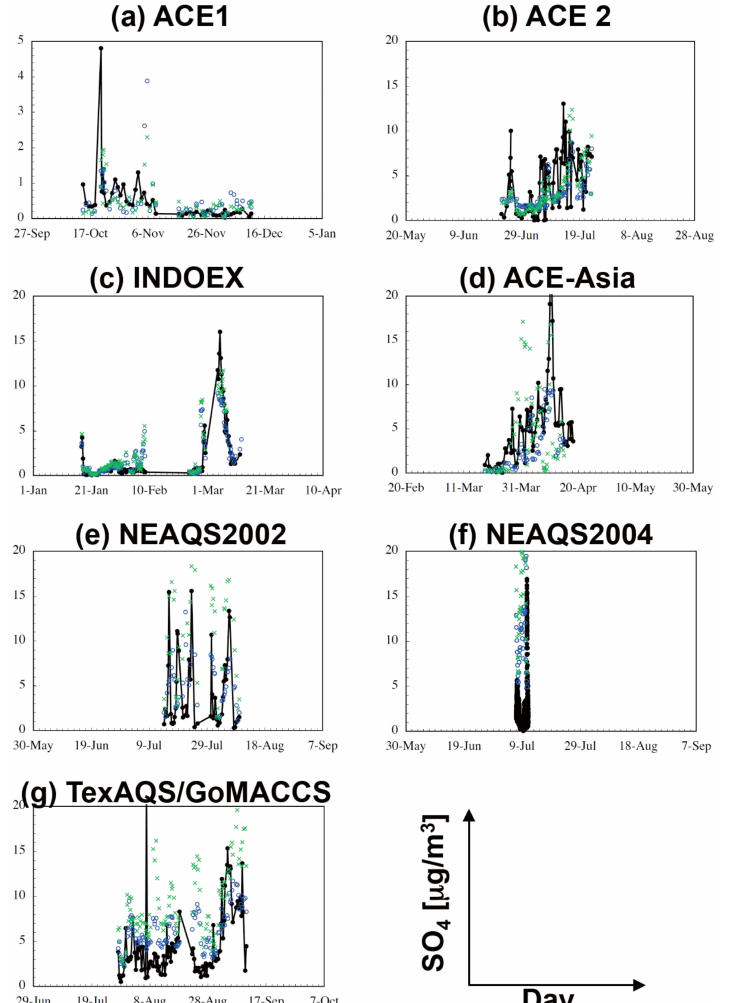
Fig. 7. Temporal sulfate mass concentrations by measurements in Quinn and Bates (2005) in black, simulations of NS in blue and simulations of OS in green, during different measurements periods (see text). The x-axis values are date and the y-axis are sulfate concentrations in µgm − 3